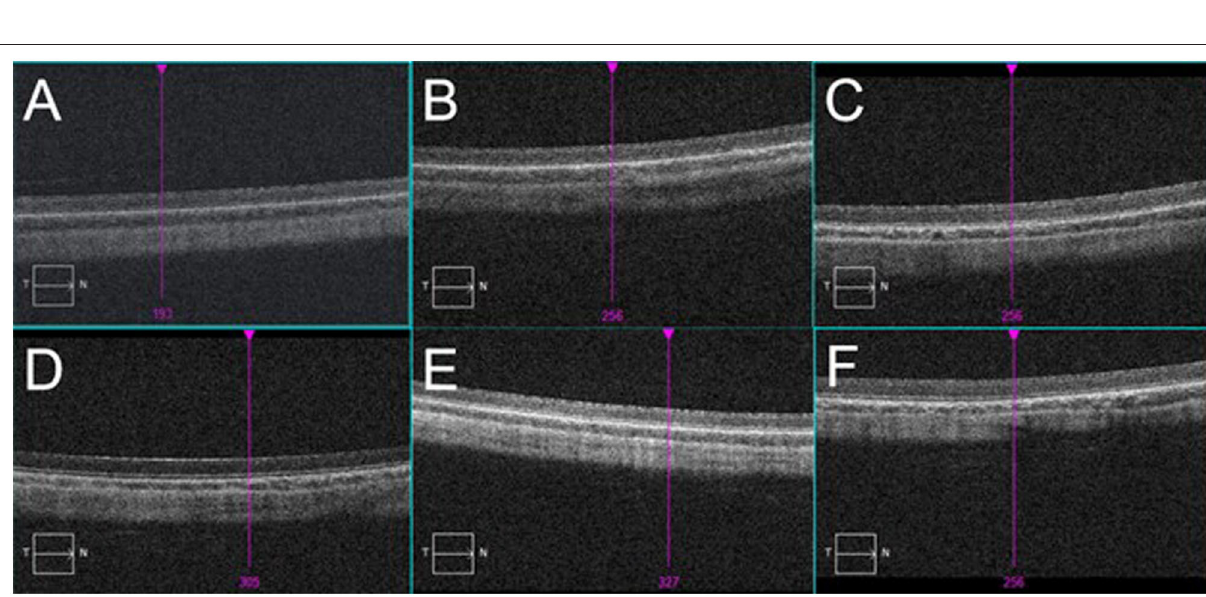
Frontiers in Medicine |